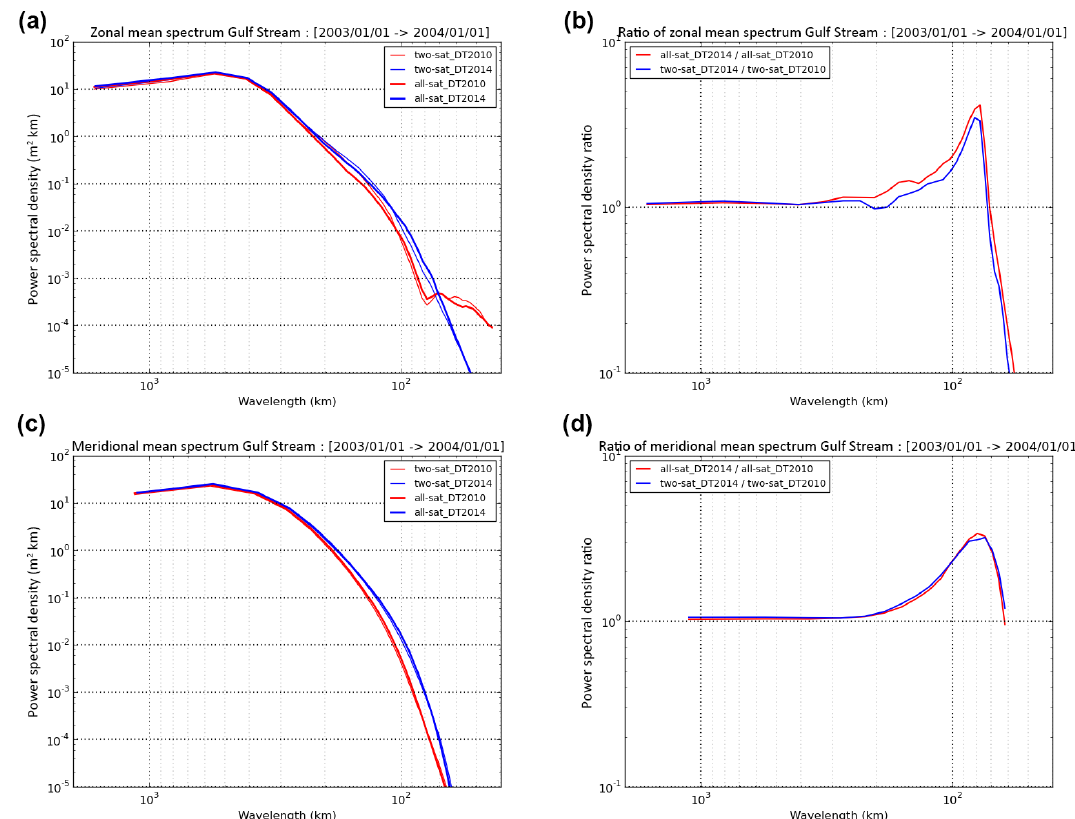
Figure 8. Mean zonal (a) and meridional (c) power spectral density (PSD) computed from gridded DT2014 (blue) and DT2010 (red) all-sat- merged (UPD; thick line) and two-sat-merged (REF; thin line) SLA fields over the Gulf Stream area during 2003 (when the constellation included J1, TP-interleaved, GFO and EN). Ratio between DT2010 and DT2014 PSD when all-sat-merged (UPD; red line) and two-sat- merged (REF; blue line) are considered: zonal (b) and meridional (d) components.